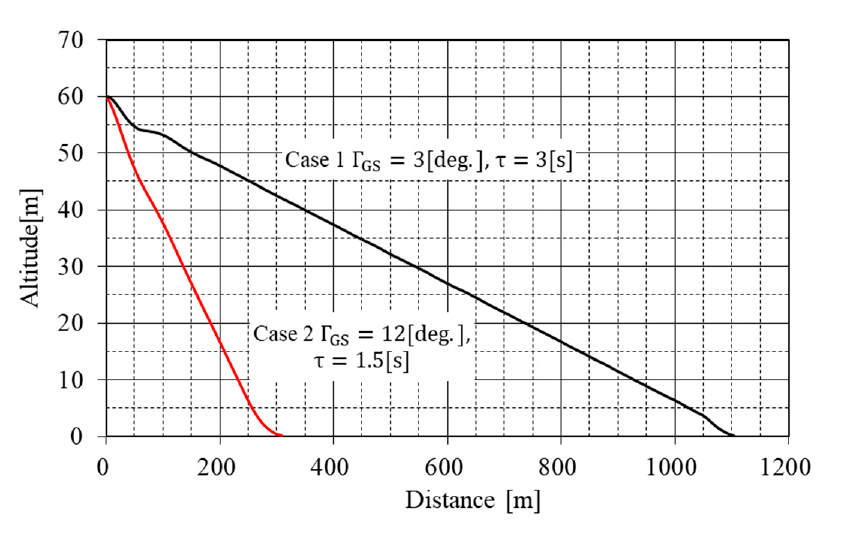
Figure 9. Vertical flight path.